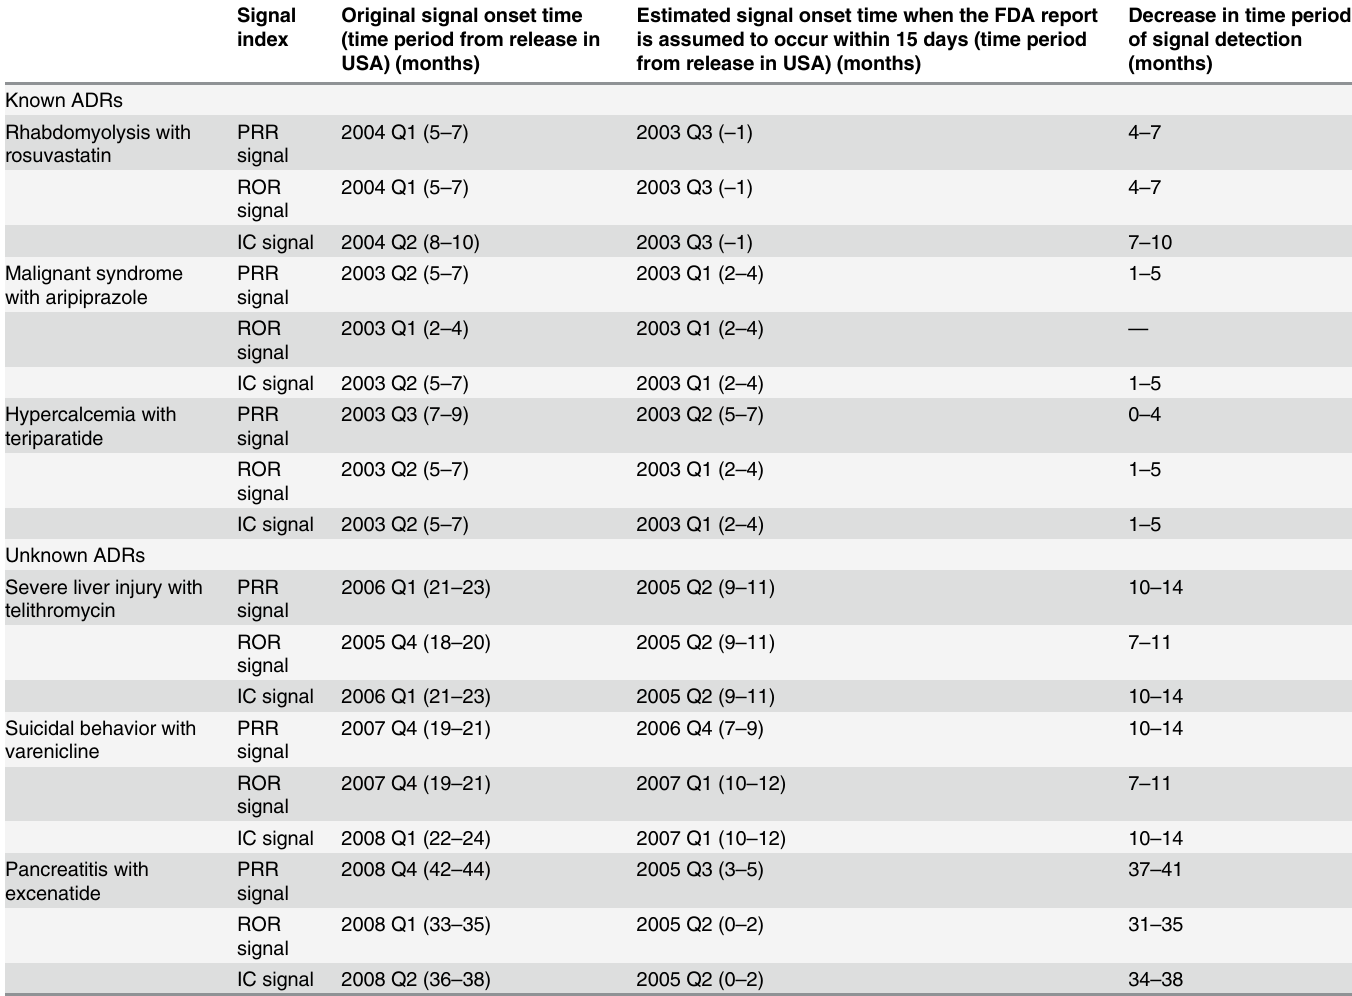
Table 2. Comparison of the time periods from initial drug release of the original signal onset time with the time period of signal detection from ini- tial drug release when the FDA report is assumed to occur 15 days after the onset of ADRs. Signal